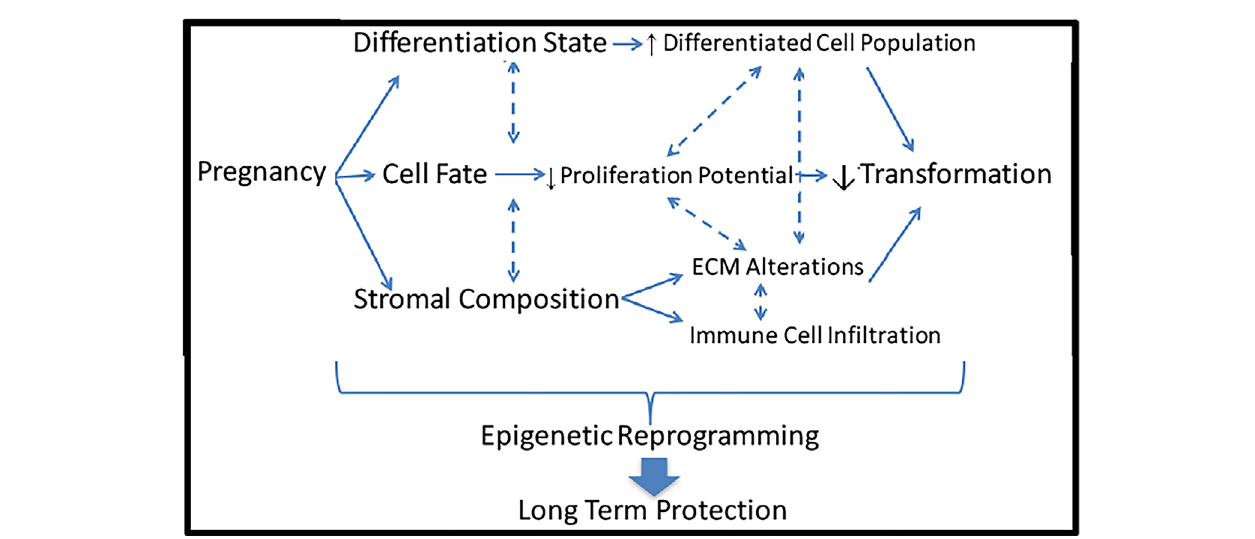
FiGURe 3 | Potential mechanisms underlying the protective effect of pregnancy against breast cancer . Pregnancy induces a multitude of dramatic changes in the breast including differentiation state, cell fate, and stromal composition. Each of these alterations could lead to reduced risk of cellular transformation and breast cancer induction. All of these mechanisms could be controlled by epigenetic reprograming, leading to long-term protective